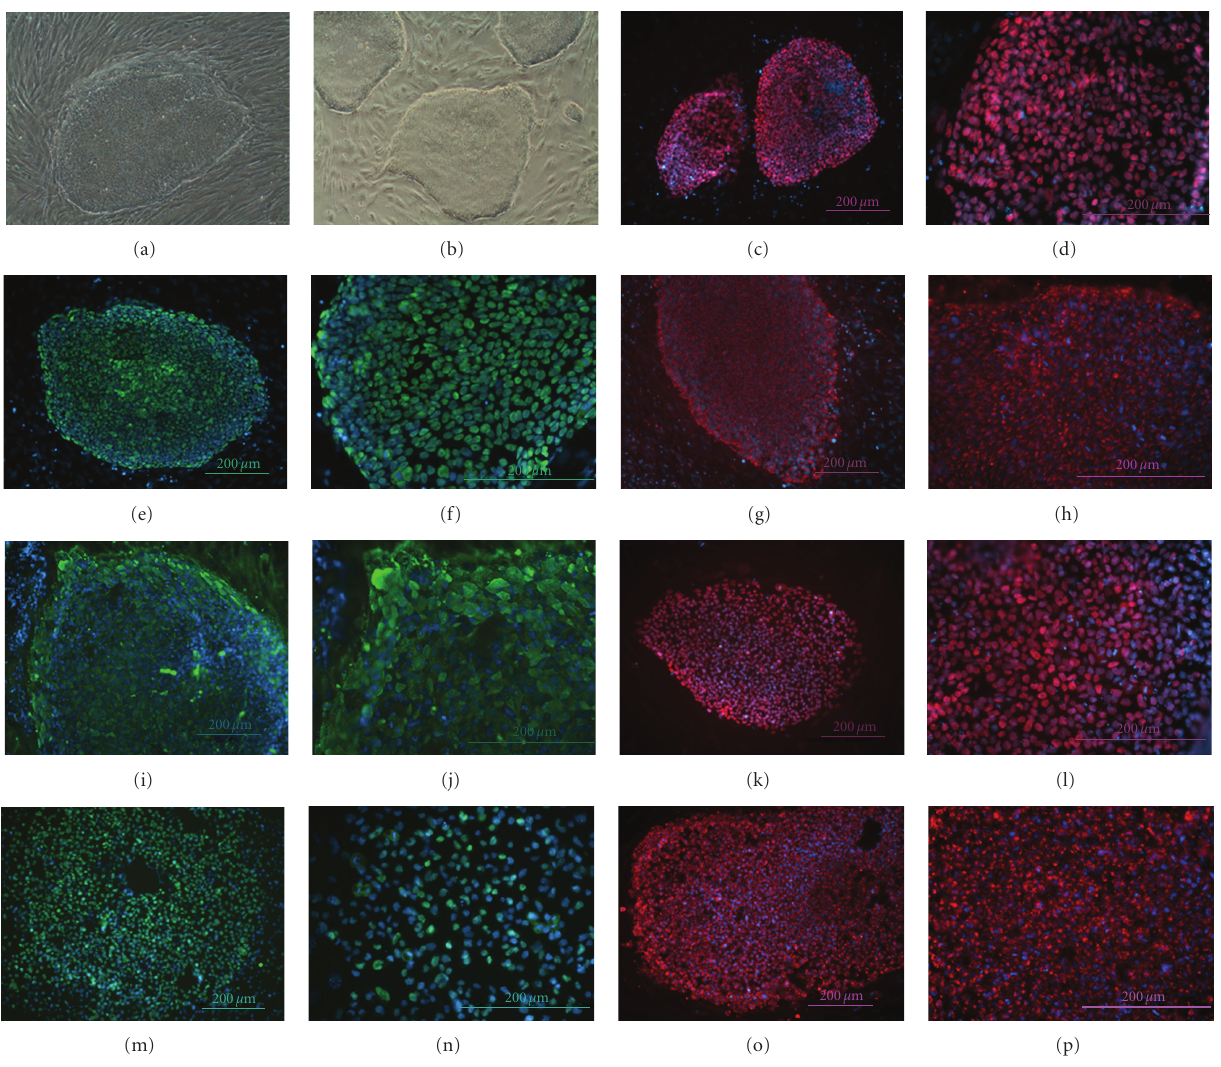
Figure 1: Undi ff erentiated H7 hESC colonies (on passage 15) 3 days after passaging on hFF feeder cells (a) and after 55 passages on MEF feeder cells (b). H7 cells passaged 11 times on hFF feeder cells expressed Nanog (c and d), Oct4 (e and f), SSEA4 (g and h), and TRA-1-60 (i and j). H7 cells on passage 45 on MEF feeder cells expressed Nanog (k and l), Oct4 (m and n), and SSEA4 (o and p). Scale bars 200 μ